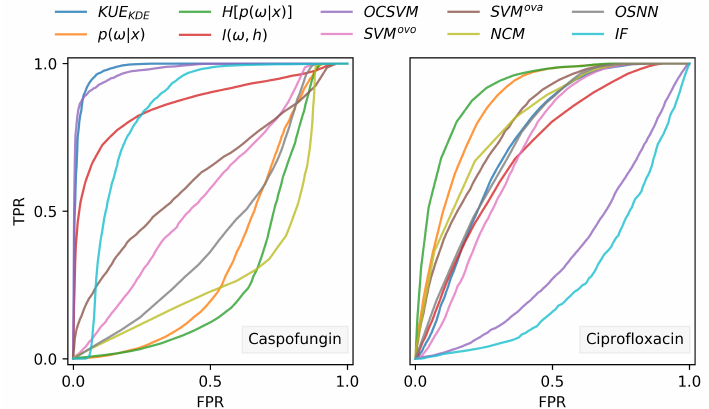
Figure 5. ROC curves for OOD detection using our KUE method and baseline methods on Caspofungin and Ciprofloxacin OOD combinations of the Bacteria dataset. Caspofungin and Ciprogloxacin represent the best and the worst performances of our KUE method,